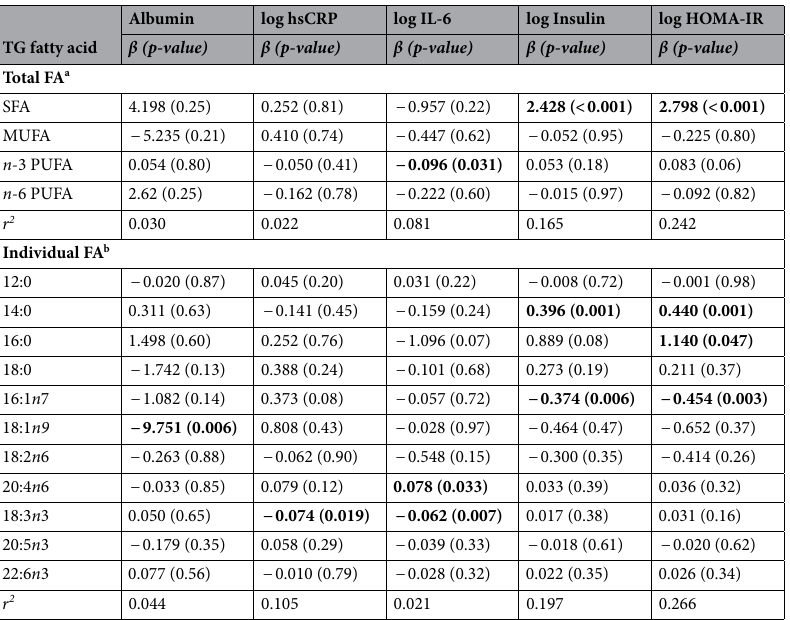
Table 3. Summary of multivariate linear regression analyses for associations between plasma TG fatty acids with biochemical variables. Multivariate linear regression analyses adjusted for age, gender, dialysis vintage, Kt/V, Charlson Comorbidity Index, prescription of statin, dialysis access, and metabolic equivalent- score. a The analysis model was concurrently inclusive of all fatty acid groups and the highest variance inflation factor was 3.178. b The analysis model was concurrently inclusive of all individual fatty acids and the highest variance inflation factor was 3.473. Values in bold indicate p -value < 0.05. FA, fatty acid, HOMA-IR, homeostatic model assessment of insulin resistance; hsCRP, high-sensitivity C-reactive protein; IL-6, interleukin-6; SFA, saturated fatty acid; TG, triglyceride. Fatty acid nomenclature: 12:0 (lauric acid), 14:0 (myristic acid), 16:0 (palmitic acid), 16:1 n -7 (palmitoleic acid), 18:0 (stearic acid), 18:1 (oleic acid), 18:2 n 6 (linoleic acid), 18:3 n 3 (α-linolenic acid), 20:4 n 6 (arachidonic acid), 20:5 n 3 (eicosapentaenoic acid), 22:6 n 3 (docosahexaenoic